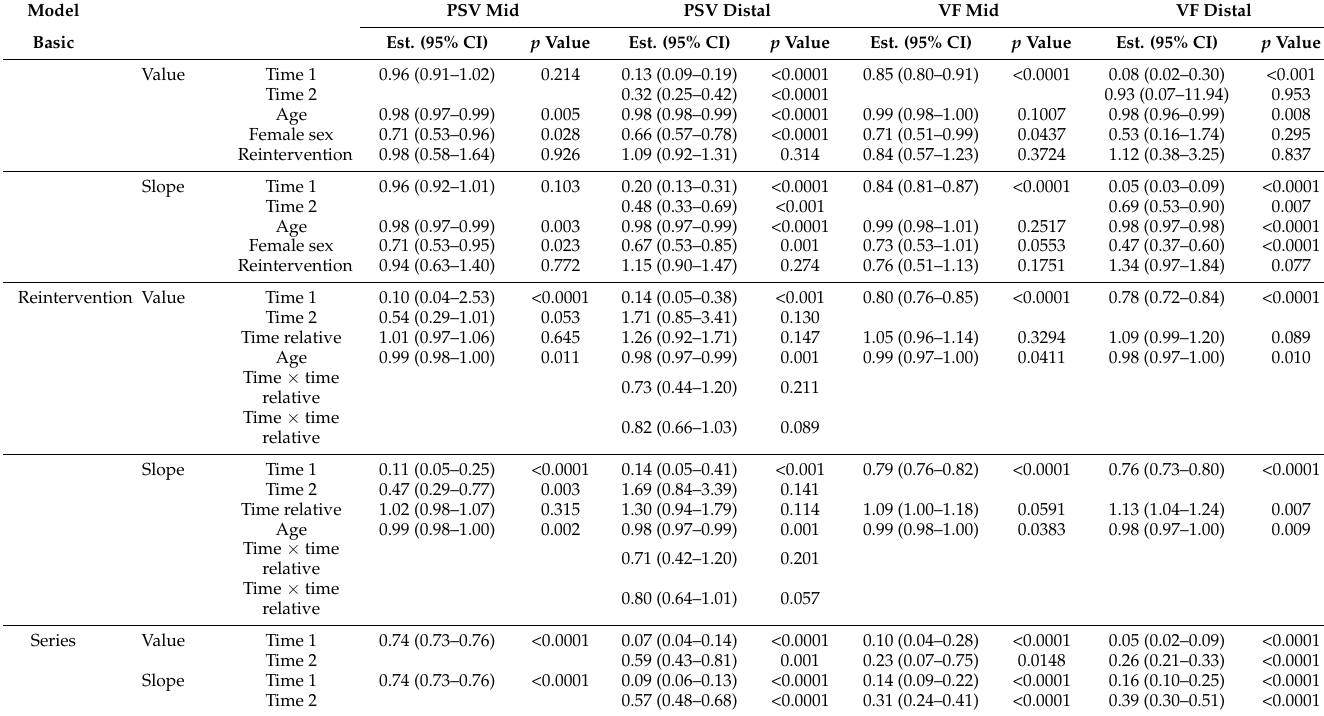
Table A1. Association between baseline characteristics and serially measured PSV and VF